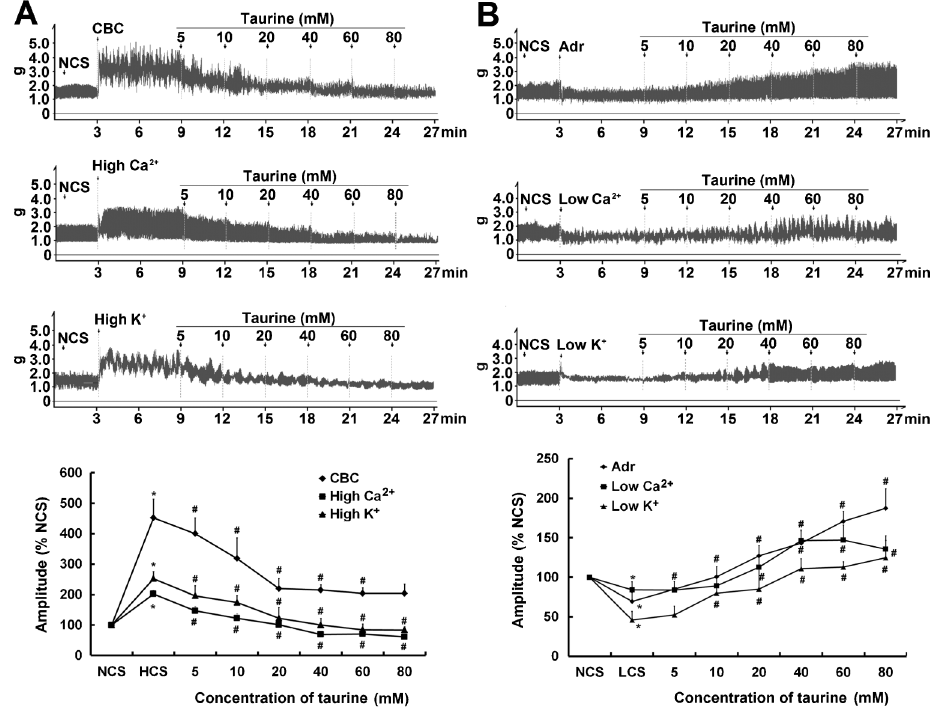
Figure 2. Taurine-inducedbidirectional modulations onthecontractileamplitude ofisolatedjejunal segments. A , Representative tracesand statistical analysis (n=6) of the inhibitory effects of taurine on the contractile amplitude of isolated jejunal segments in 3 high contractile states (HCS). B , Representative traces and statistical analysis (n=6) of the stimulatory effects of taurine on the contractile amplitude of isolated jejunal segments in 3 low contractile states (LCS). The contractile amplitude in the normal contractile state (NCS, control) is set to 100%; the contractile amplitude in HCS and LCS are the relative values compared with NCS. CBC: carbachol; Adr: adrenaline. *P , 0.05 vs the contractile amplitude in NCS; # P , 0.05 vs the contractile amplitude in LCS or HCS before taurine administration (one-way